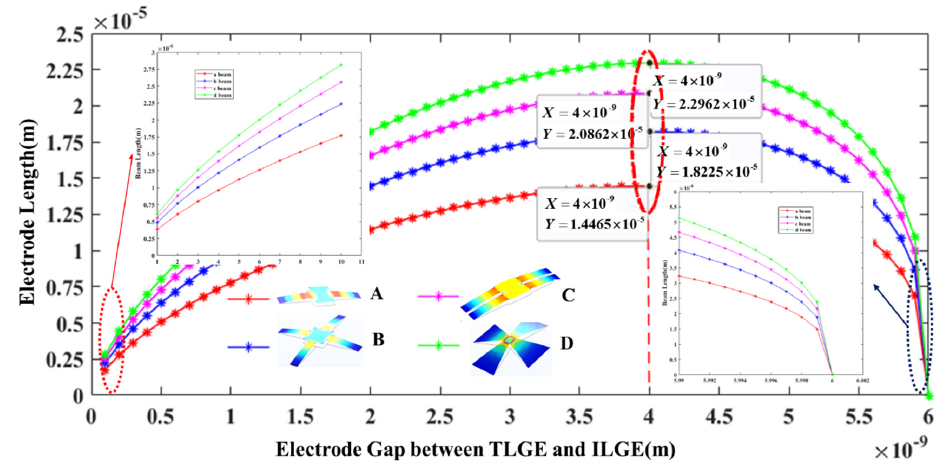
Figure 3. Relationship between the electrode length and the motion displacement.